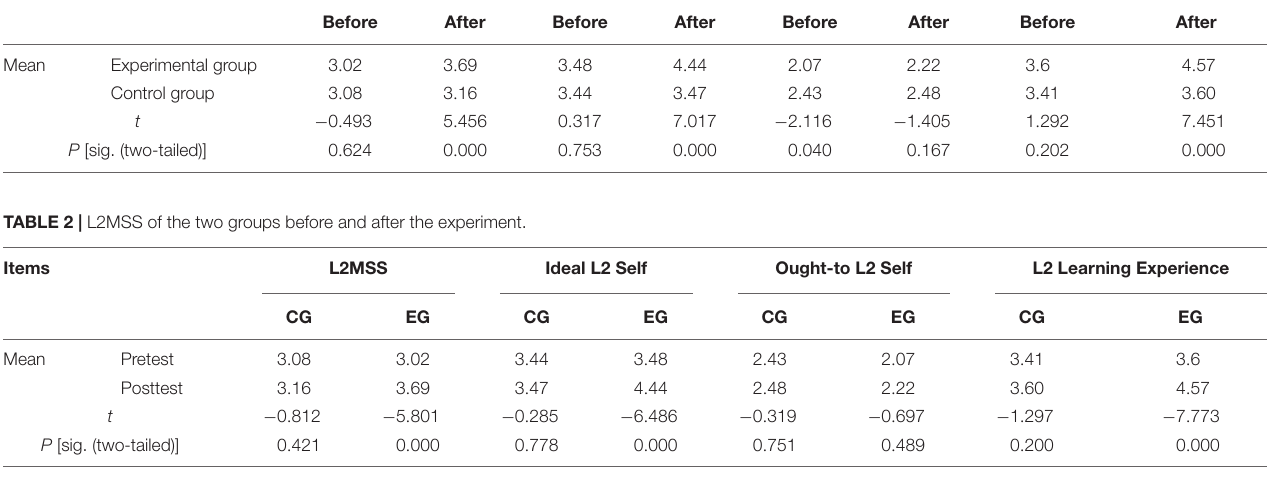
TABLE 1 | Second language motivational self system (L2MSS) between the two groups before and after the experiment. L2MSS Ideal L2 Self Ought-to L2 Self L2 Learning Experience Before After Before After Before After Before After